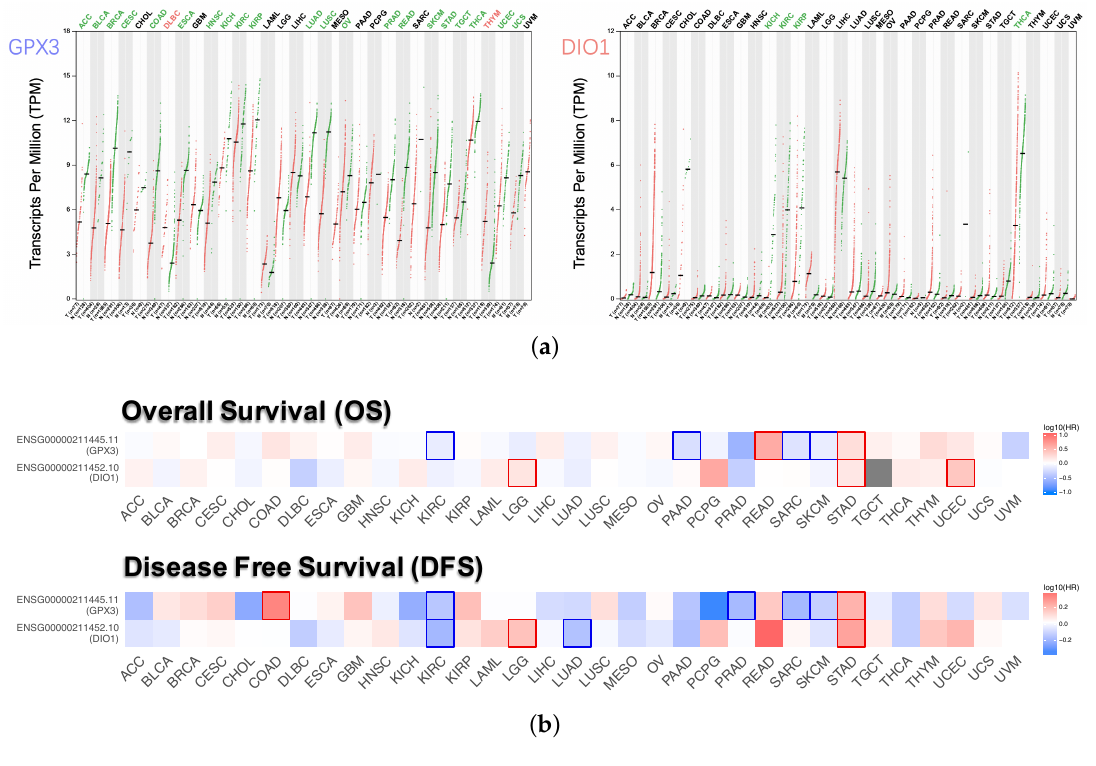
Figure 3. Expression level and survival analysis of GPX3 and DIO1 across 33 TCGA cancer types (GEPIA2). ( a ) Dot plots of GPX3 and DIO1 differential expression levels in 33 cancer types (TCGA) compared to the normal (TCGA normal and GTEx). Each dot represents a distinct tumor (pink) or normal sample (green). The abscissa represents the sample from tumor tissue (T) or normal tissue (N), and “n” represents the sample size. The ordinate represents the amount of transcript expression in ( TPM + 1 ) transformed. Above the table are the TCGA the sample, and the expression data were log 2 abbreviations of the cancer names. The cancer name coding in green indicates that the target gene has relatively lower expression in the tumor tissue, and the red indicates higher expression. We